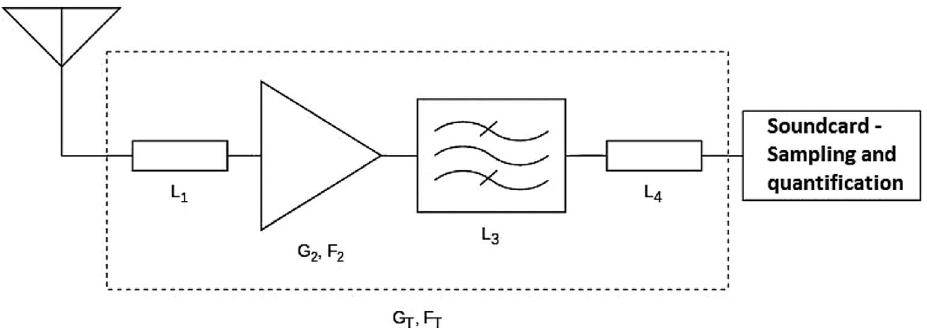
Fig. 2. Simpli fi ed block diagram of the complete